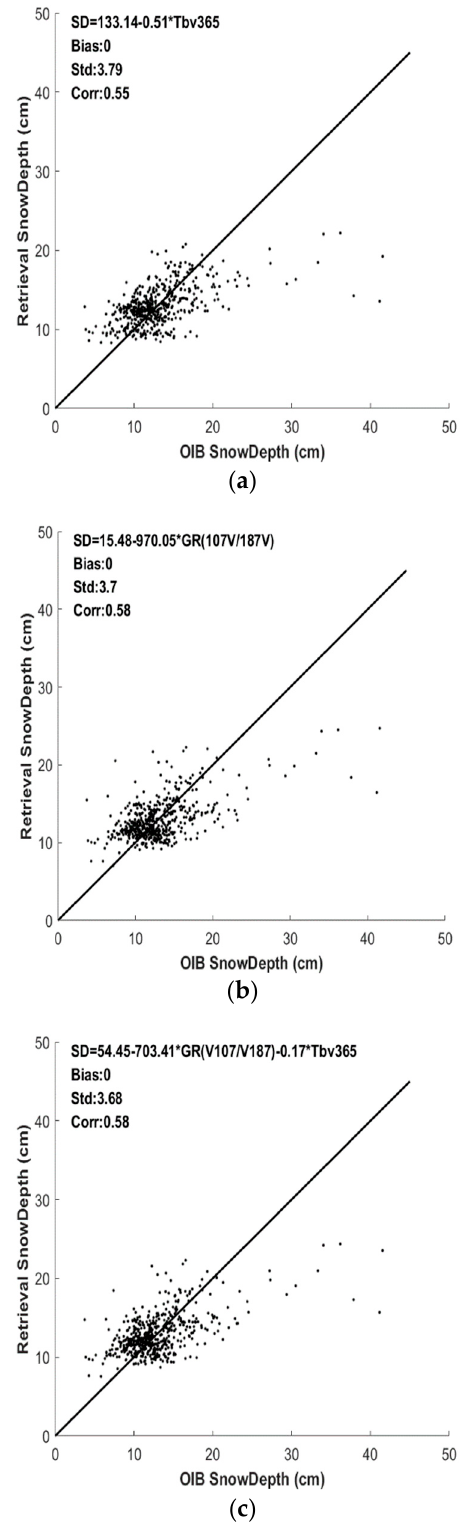
Figure 10. Fitting results on FYI. ( a – c ) correspond to Equations (2)–(4), respectively.